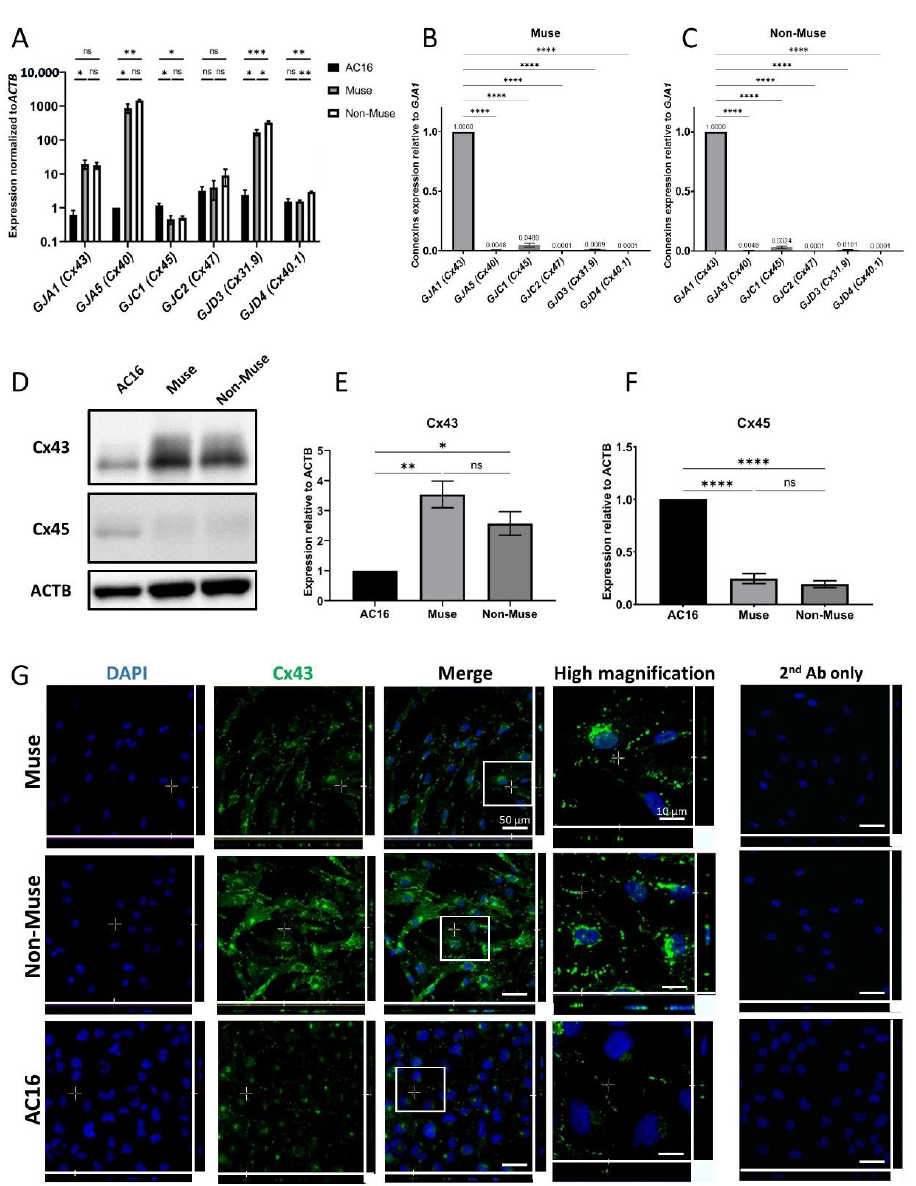
Figure 1. Expression of connexin-encoding genes in human cardiomyocyte, Muse and non-Muse cells, derived from hMSCs. ( A ) qPCR shows the expression of gap junction alpha-1 protein ( GJA1) and other genes encoding for gap junction proteins in Muse and Non-Muse cells. Human Cardiomyocytes cell line (AC16) cells were used as a positive control ( n = 3). *: p < 0.05, **: p < 0.01, ***: p < 0.001, ns: no significant difference; ( B , C ) The relative expression of connexin encoding gene in Muse cells ( B ), and Non-Muse cells in qPCR ( C ). The expression of each gene was normalized by ACTB .